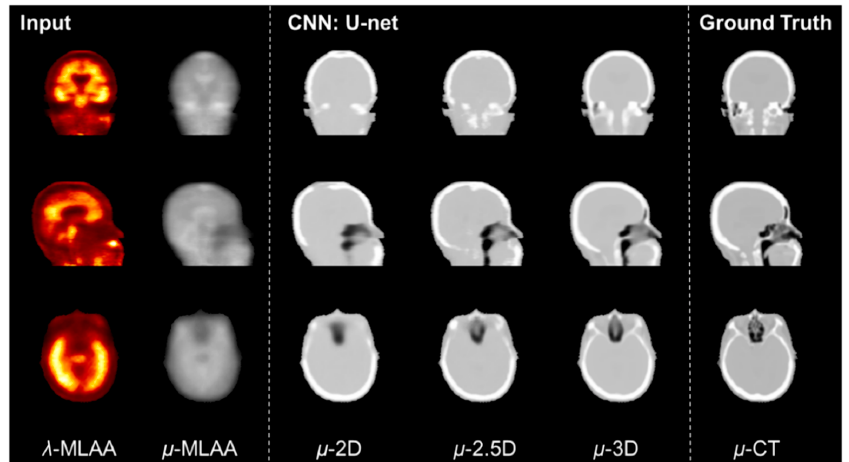
Figure 2. Comparison of output images ( μ -maps) from different network models. Cross-talk artifacts are severe and μ -values are underestimated in μ -maps of maximum likelihood reconstruction of activity and attenuation ( μ -MLAA), which were mitigated by convolutional neural network (CNN). Table 1. Dice similarity coefficients with the CT-derived μ -map ( μ -CT).